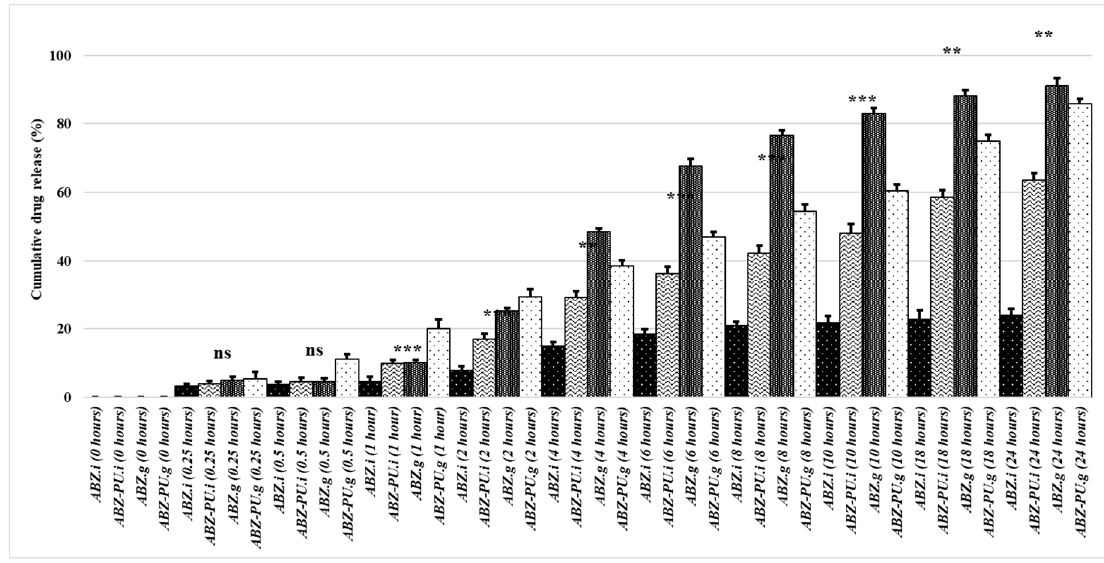
Figure 9. Comparative dissolution studies between pure ABZ and ABZ-PU formulations in simulated gastric / intestinal media, respectively, at di ff erent time points using one way ANOVA test. Values are mean ± SD. p > 0.05 not significant (ns), p ≤ 0.05 (*), p ≤ 0.01 (**), and p ≤ 0.001